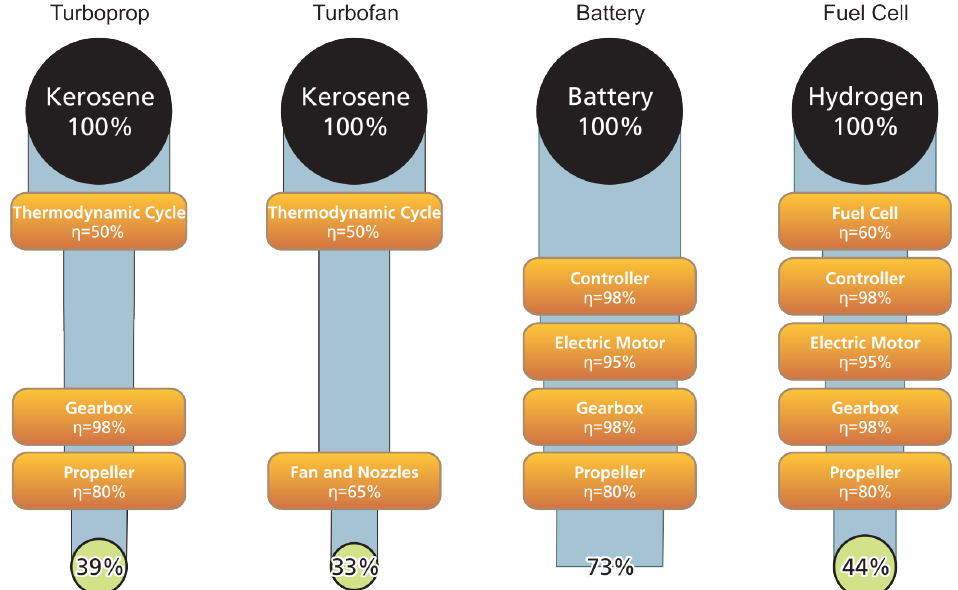
Figure 7. Typical onboard conversion chains with typical component efficiencies and total chain efficiency [34]. Credits: